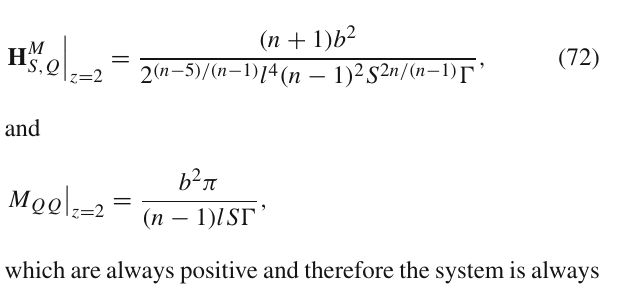
Fig. 12 The behavior of the Ruppeiner invariant R versus T for the Born–Infeld case with z = 2 and l = b =